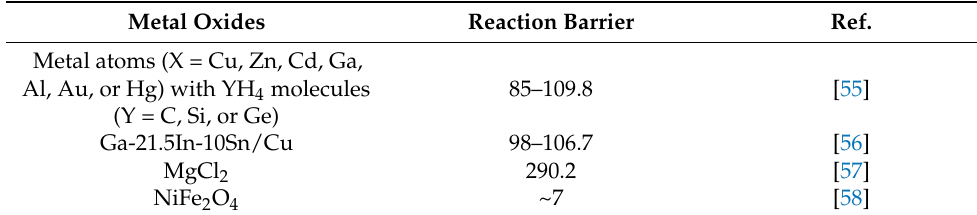
Table 3. Metal reaction barrier.